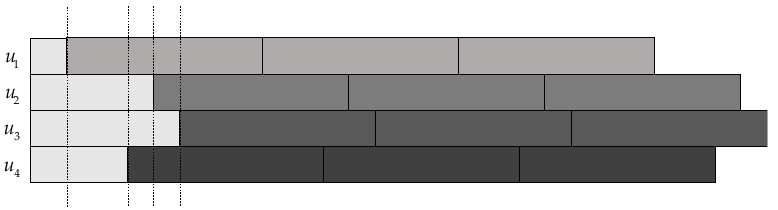
Figure 1. Different delays in the detection of asynchronous multi-users.